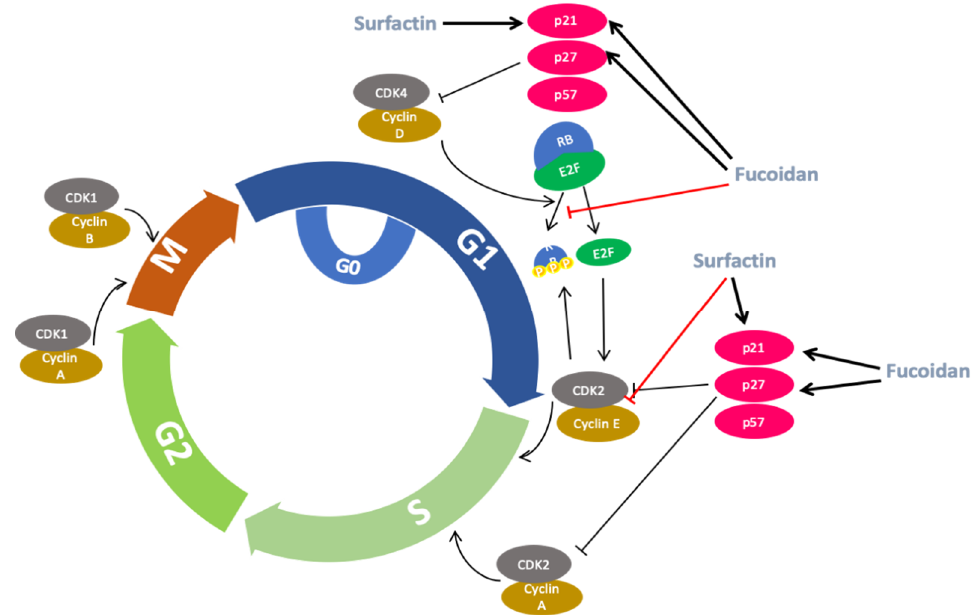
Figure 3. Anti-cancer activity of marine-derived SAAs through regulation of cell cycle progression. Surfactin and fucoidan exhibit anti-cancer activity by blocking cell cycle progression through up-regulation of inhibitor(s) levels of CDKs. In addition, fucoidan induce G1 phase cell cycle arrest, through inhibition of RB phosphorylation. pRB, phosphorylated retinoblastoma; CDKs 4,2,1, Cyclin-dependent kinases 4,2,1; E2F, E2 promoter binding Factor.